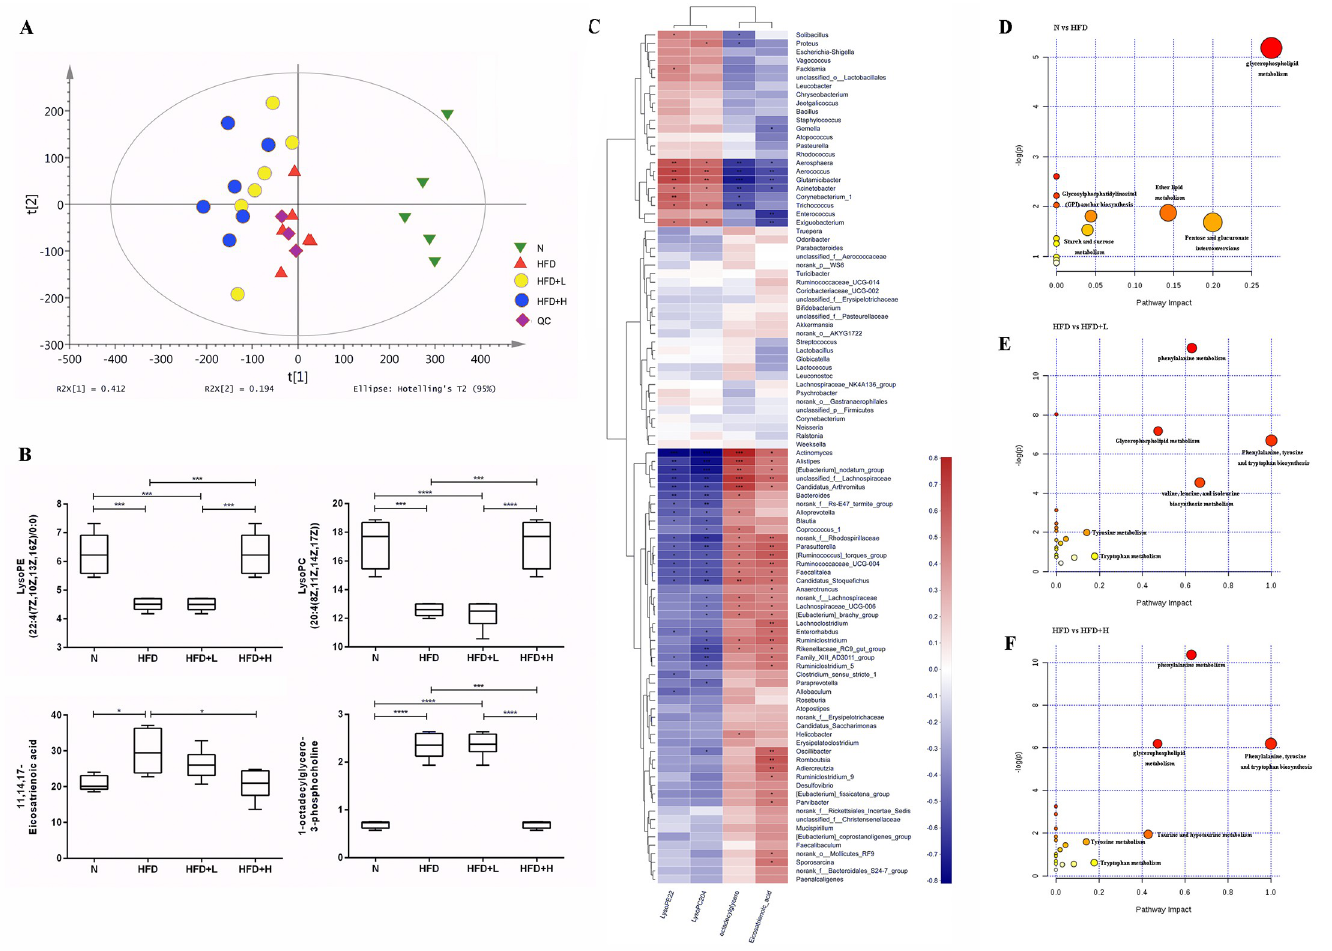
Fig 5. Pronounced metabolomic shift in response to hyperlipidemia and YNKB treatment. (A) PCA analysis of serum metabolites; (B) Four metabolites with differential abundance between the normal and HFD groups, restored by YNKB administration; (C) Spearman’s correlation between the identified four metabolites and microbiota at the genus level. The color of the squares represents the R-value of Spearman’s correlation. The pathway set enrichment analyses were performed using Metabolanalyst (www.metabolanalyst.ca) to elucidate the metabolic pathways affected by metabolite distinctions between the normal, HFD, and YNKB treatment groups; (D) The analysis between the N and HFD groups; (E) The analysis between the HFD and HFD+L groups; (F) The analysis between the HFD and HFD+H groups. � p < 0.05, �� p < 0.01, ��� p < 0.001.